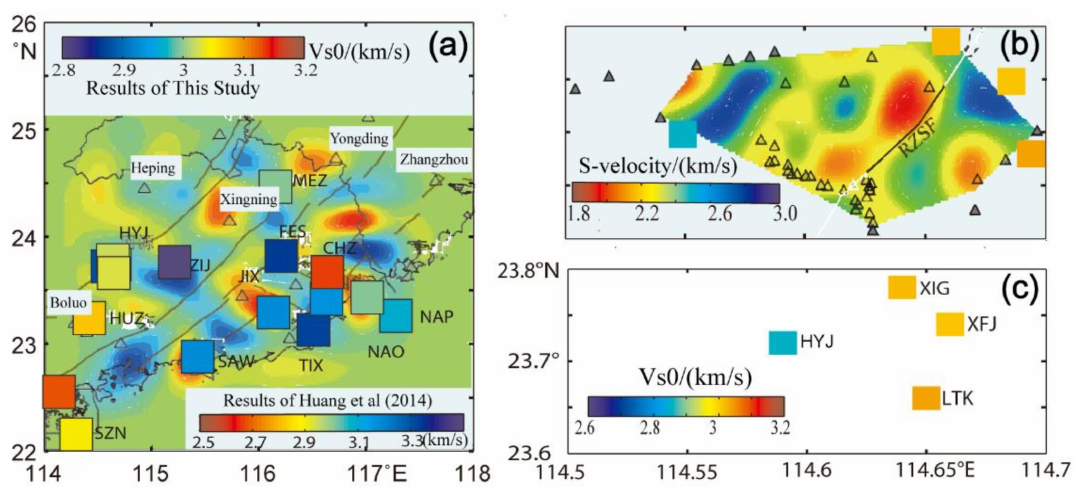
Figure 9. Comparisons of SWVs and Rayleigh wave velocity groups of ambient noise tomography in a similar area. The two colored bars in ( a ) are consistent. ( a ) The bottom map is the result of ambient noise tomography by Huang et al. [38] in eastern Guangdong Province; ( b ) the bottom map is a result of ambient noise tomography by He et al. [13] in XFJR; ( c ) finding of Vs 0 in this study in the